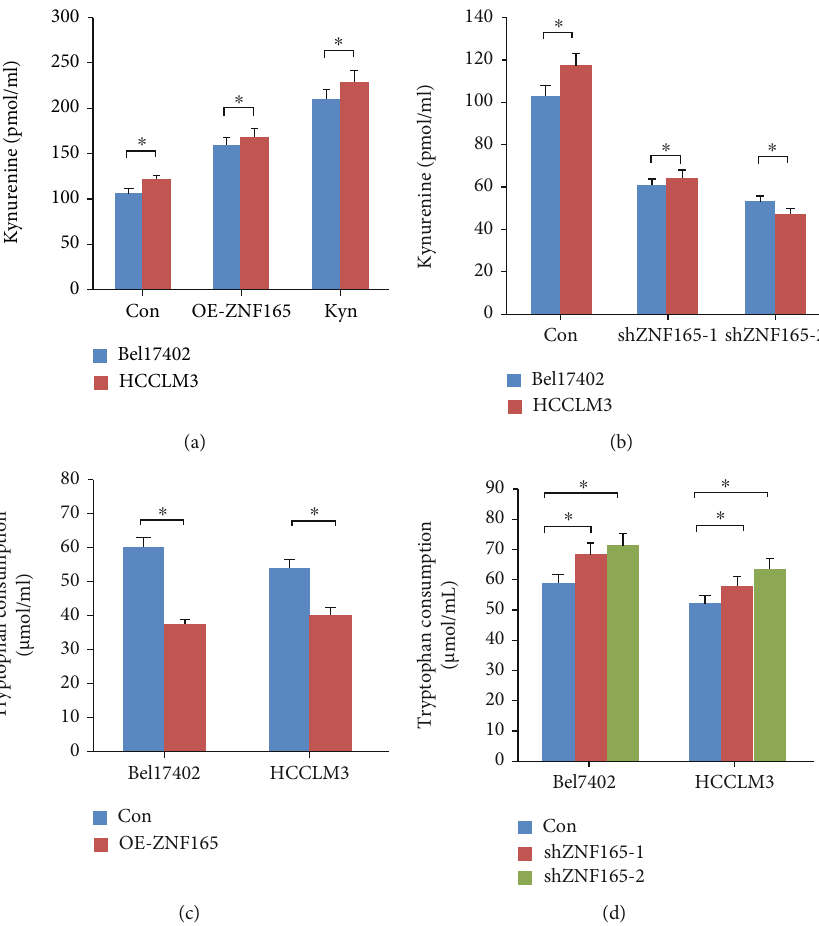
Figure 5: ZNF165 a ff ects tryptophan metabolites. (a, b) Signi fi cantly decreased kynurenine content in the supernatant of cells knocked down with ZNF165 was detected, whereas increased kynurenine content was detected in the supernatant of cells overexpressing ZNF165. (c, d) A signi fi cant increase in tryptophan content in the supernatant of cells with knocked down ZNF165 was detected, whereas increased tryptophan content was detected in the supernatant of cells overexpressing